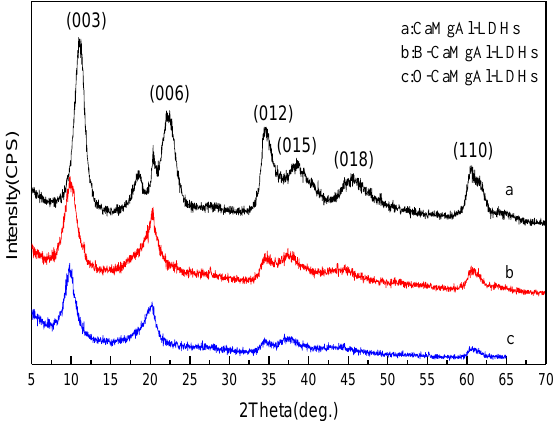
Figure 1. XRD patterns of CaMgAl-LDHs, B-CaMgAl-LDHs, and O-CaMgAl-LDHs.